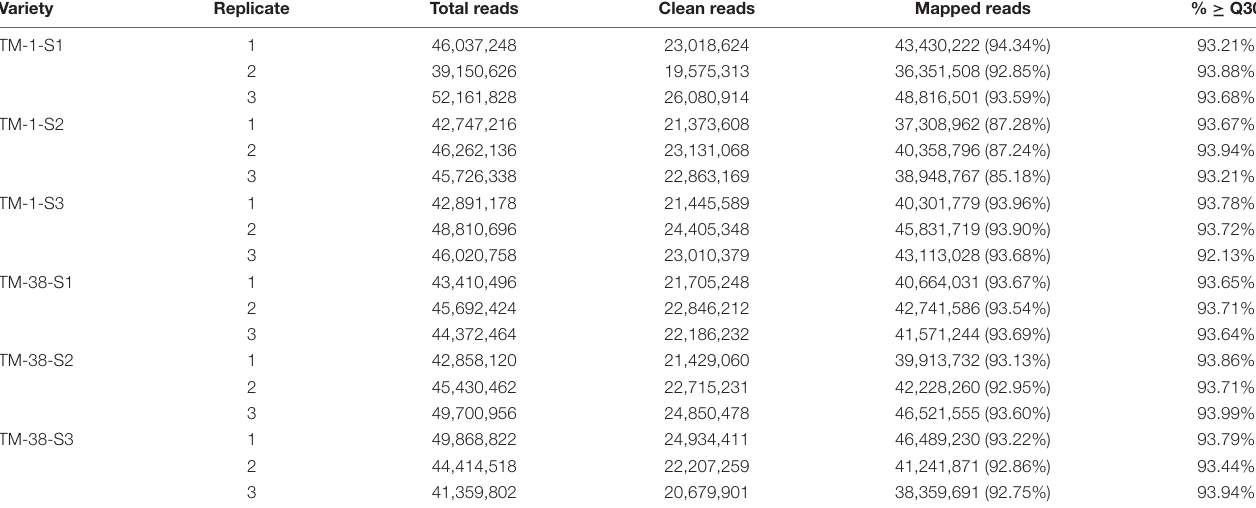
TABLE 1 | Summary of RNA-Seq data and mapping metrics. Variety Replicate Total reads Clean reads Mapped